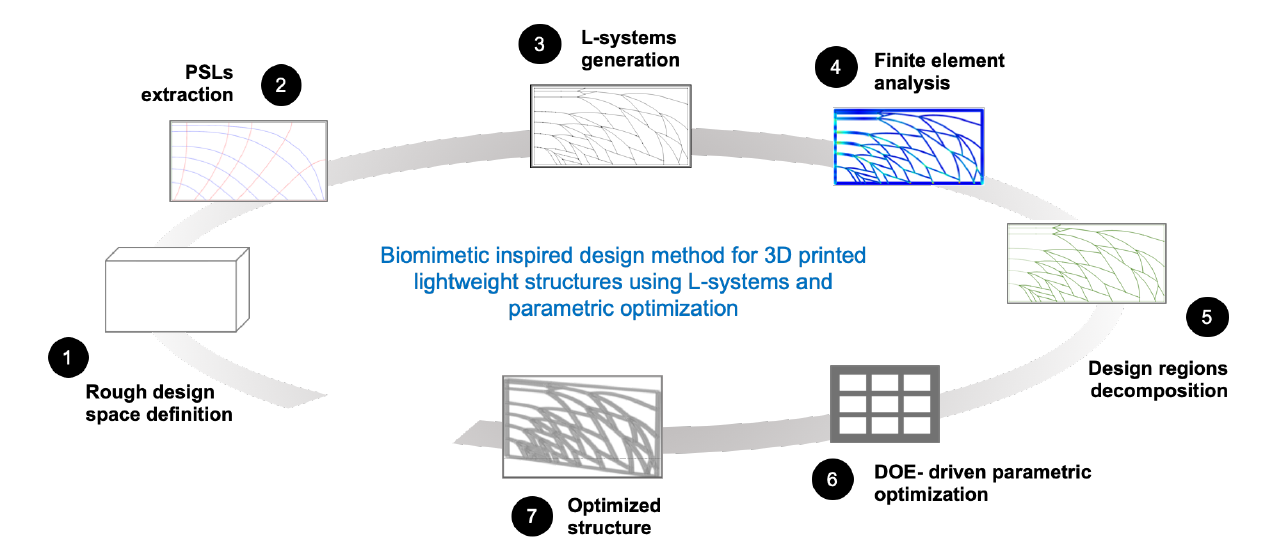
Figure 1. Overview of the proposed computational design method for AM of lightweight structures using L-systems and parametric optimization.